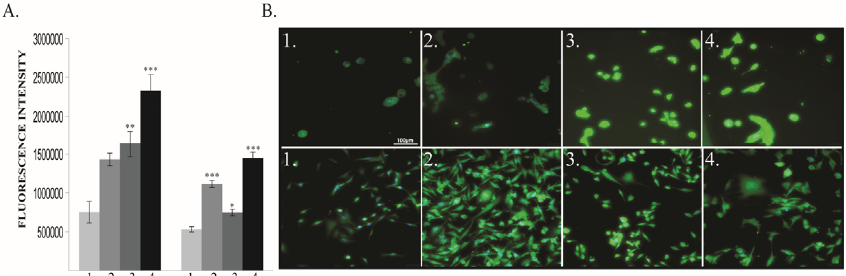
Figure 6. VEGF-R2 protein expression. ( A ) Protein quantification: left MCF10A, right MDA-MB-231; ( B ) Immunofluorescence pictures: upper panel MCF10A, lower panel MDA-MB-231; 1 — 21% O 2 , 2 — 40% O 2 , 3 — 60% O 2 , 4 — 80% O 2 . * p < 0.05, ** p < 0.005, *** p < 0.0005.